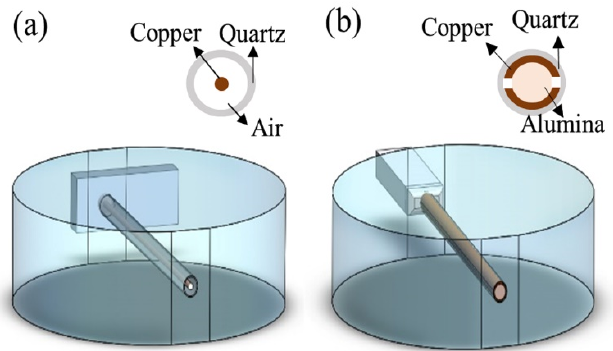
Figure 2. Schematic diagram of microwave plasma source. ( a ) Quasi-coaxial TEM linear MWP and ( b ) circular TE 11 waveguiding structure.